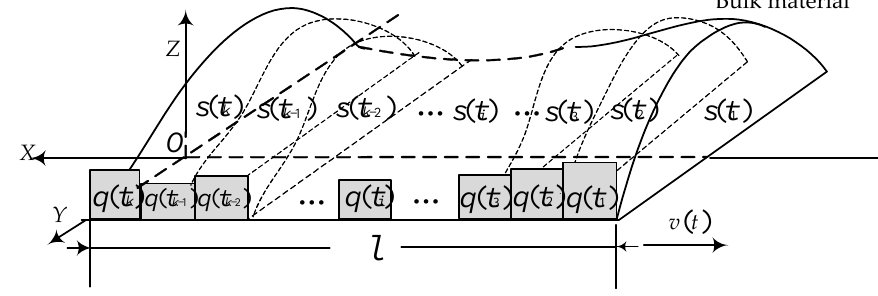
Figure 4. Schematic diagram of the micro-units of a non-uniform bulk material distribution on the conveyor belt.